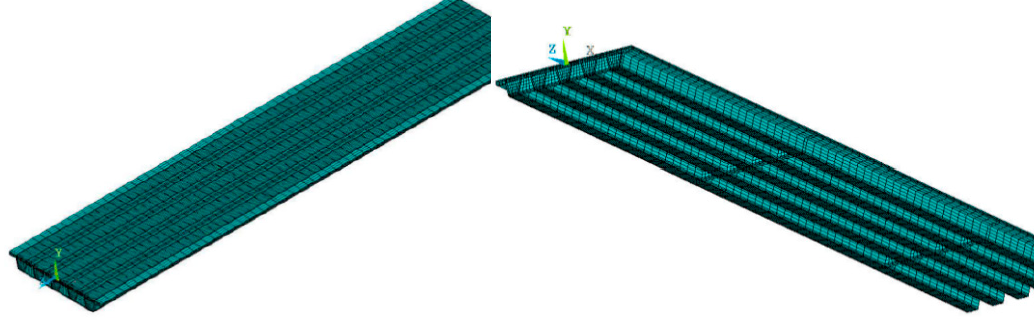
Figure 7. The 3D Finite Element model of the PC box girder.